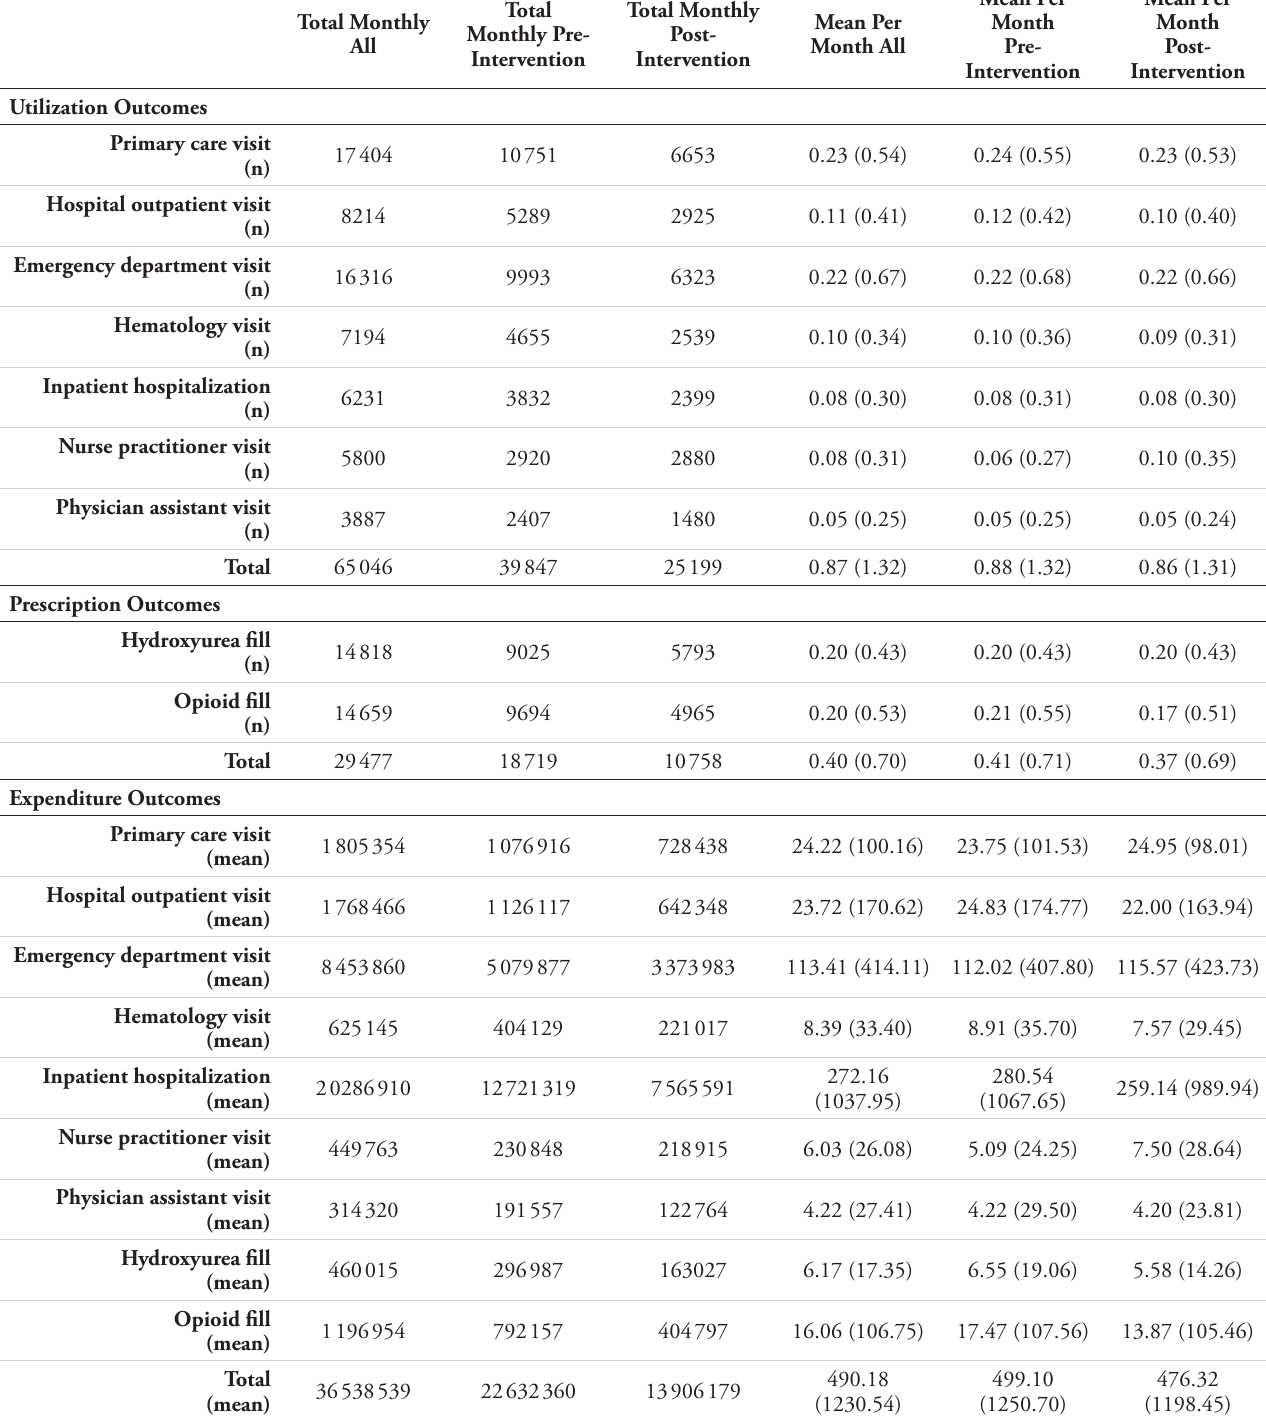
Table 2. Description of Monthly Utilization and Cost Outcome Variables Pre- and Post-Intervention